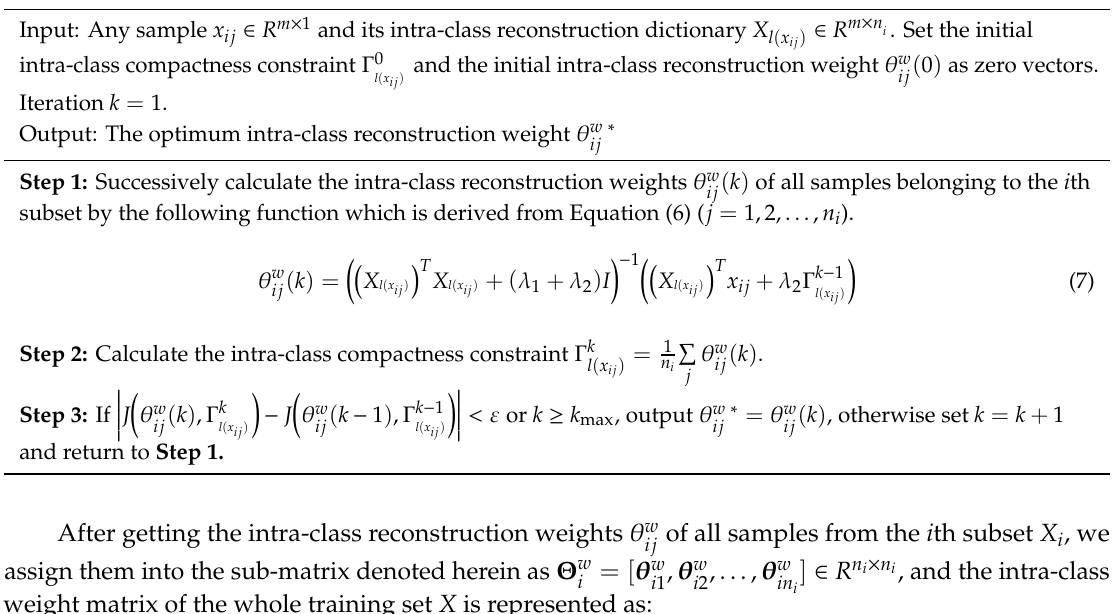
Algorithm 1 The intra-class reconstruction weight optimization algorithm (Solving Equation